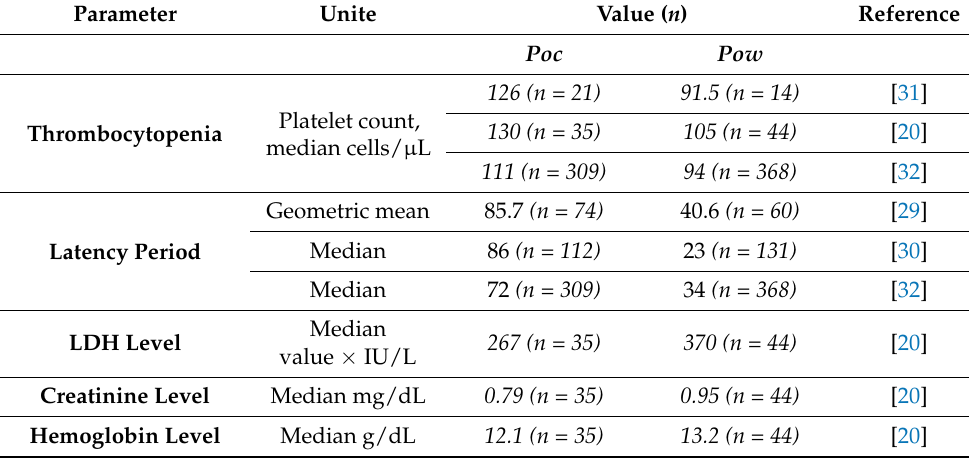
Table 2. Some significantly different reported parameters between Poc and Pow